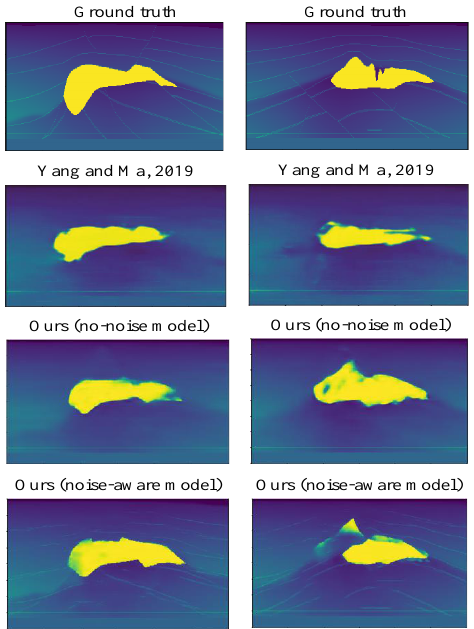
Figure 13. Comparison of reconstructions between our work and Yang and Ma